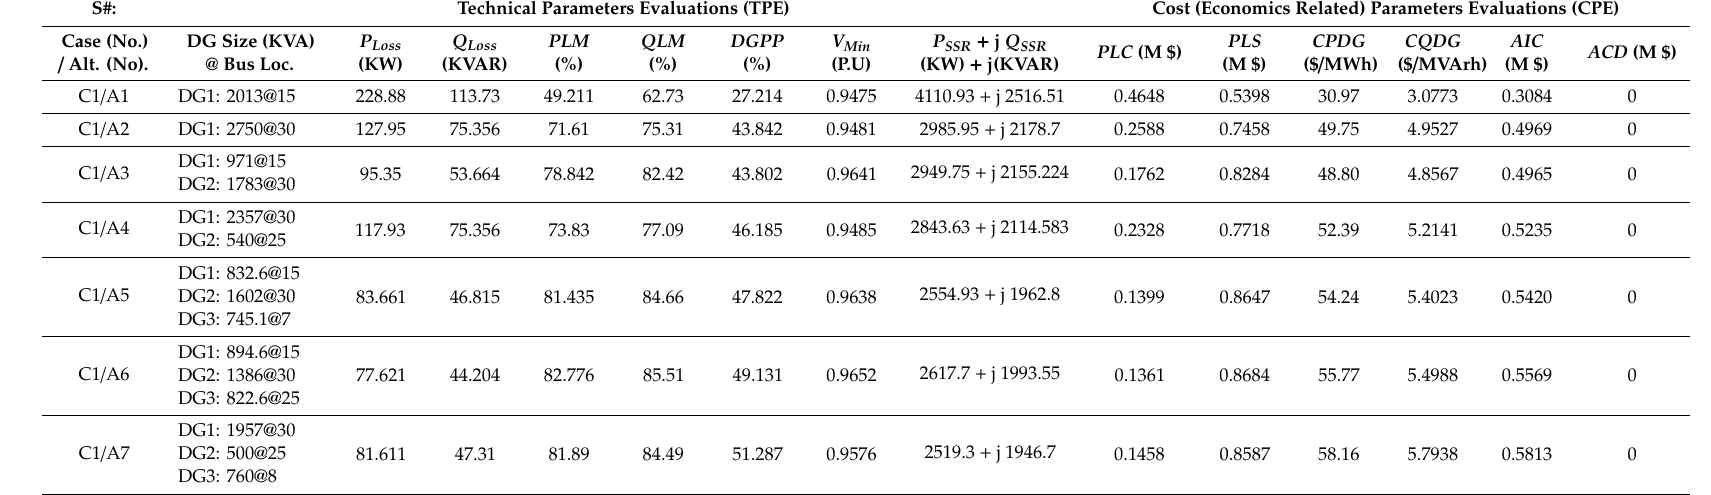
Table 13. Techno-economic evaluation analysis in case 1 (C1_LG) for 33-bus